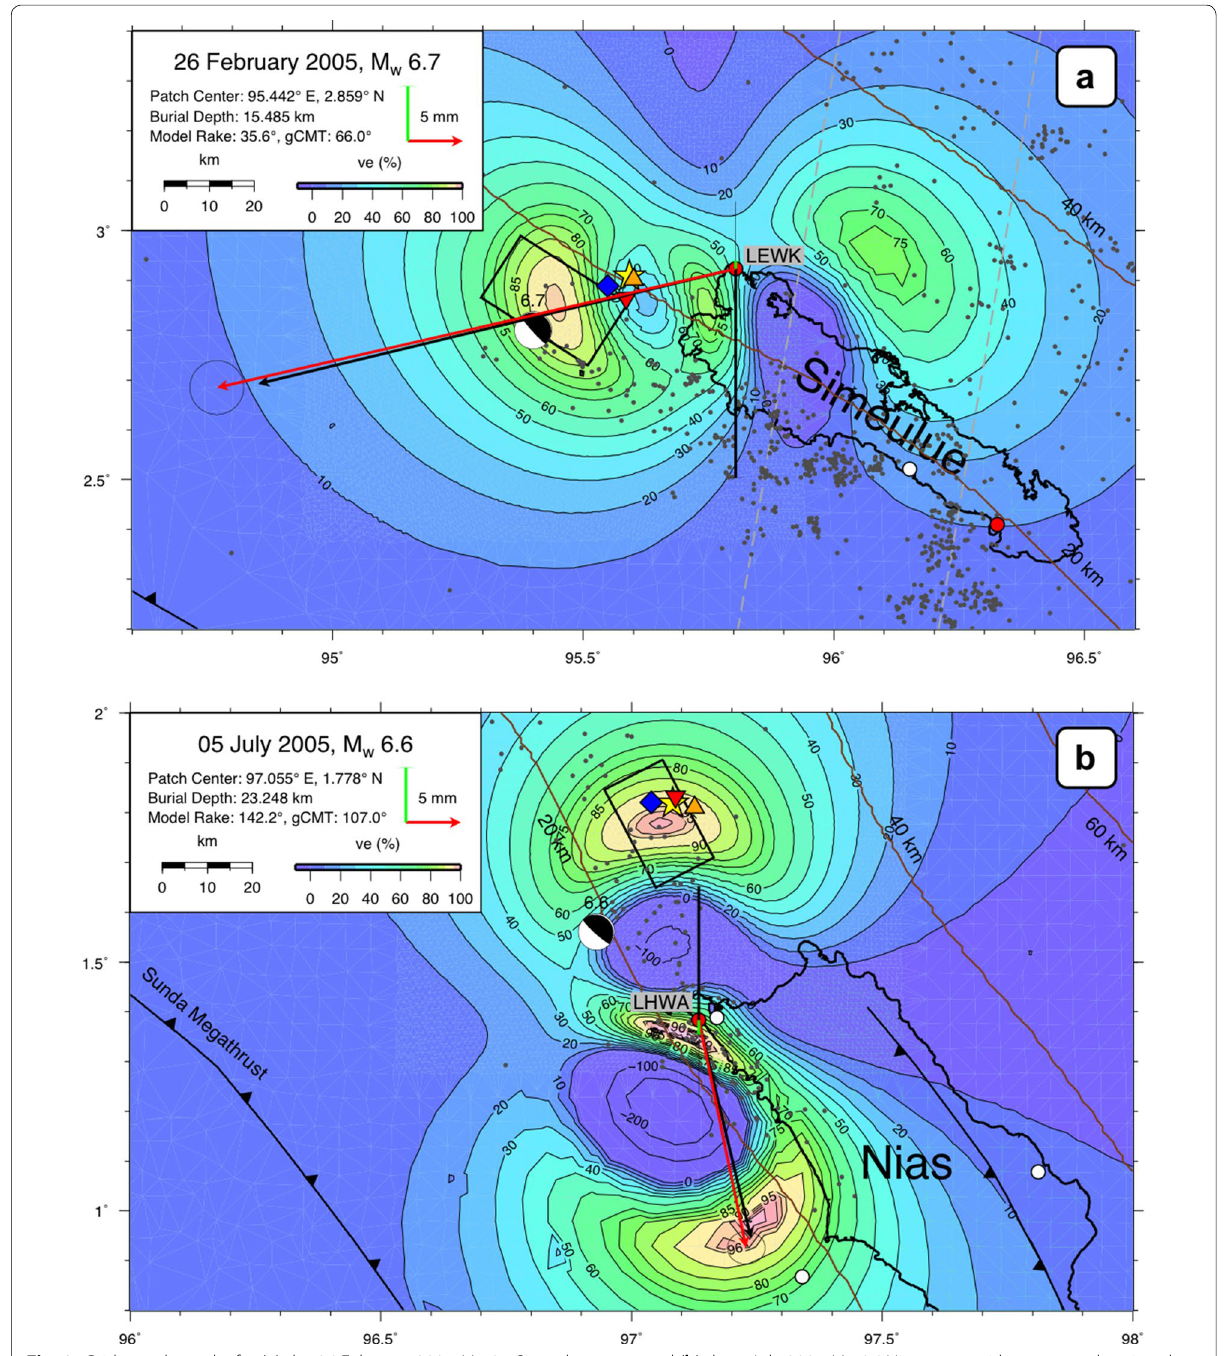
Fig. 2 Grid-search results for ( a ) the 26 February 2005 M w 6.7 Simeulue event and ( b ) the 5 July 2005 M w 6.6 Nias event with contours showing the error-weighted variance explained (ve) of numerous forward models. Black boxes outline the surface projection of the preferred rupture plane. Red circles are the SuGAr stations that had been installed before the event, while white circles are those installed after the event or decommissioned before the event. Green and red vectors represent the observed vertical and horizontal displacements, while black vectors represent the displacements predicted from our preferred model. Yellow stars, orange triangles, blue diamonds, and red inverted triangles represent the epicenters from the ANSS, ISC, ISC-EHB, and ISC-GEM teleseismic catalogs, respectively. Focal mechanisms are placed at the gCMT centroid locations (Dziewonski et al. 1981; Ekström et al. 2012). Both events have three local maxima in their contours. The global maximum for the Simeulue event is the closest to the teleseismic locations; thus, the global maximum is chosen as the preferred model. However, the global maximum near LHWA for the Nias event is only the second closest to the teleseismic locations; thus, the local maximum closest to the teleseismic locations is chosen as the preferred model. Brown lines are slab contours at 20 km, 40 km, and 60 km intervals from Slab1.0 (Hayes et al.